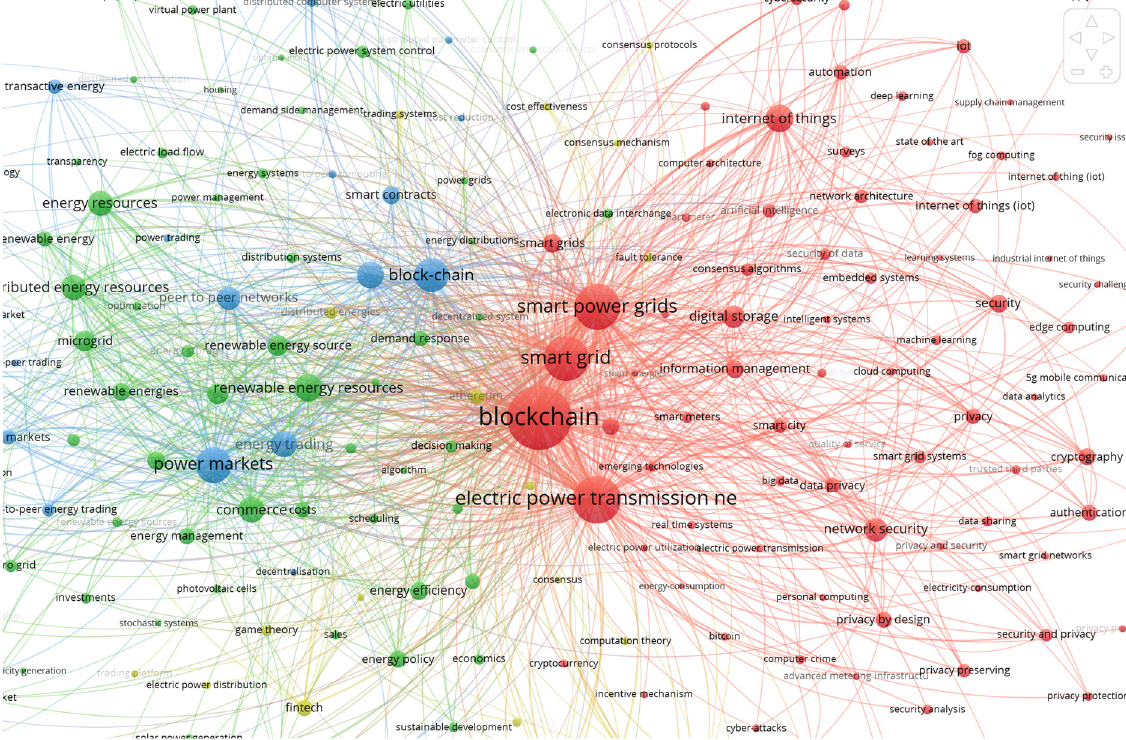
Figure A2. Keyword co-occurrence analysis (using VOS Viewer)—a zoomed-in view.